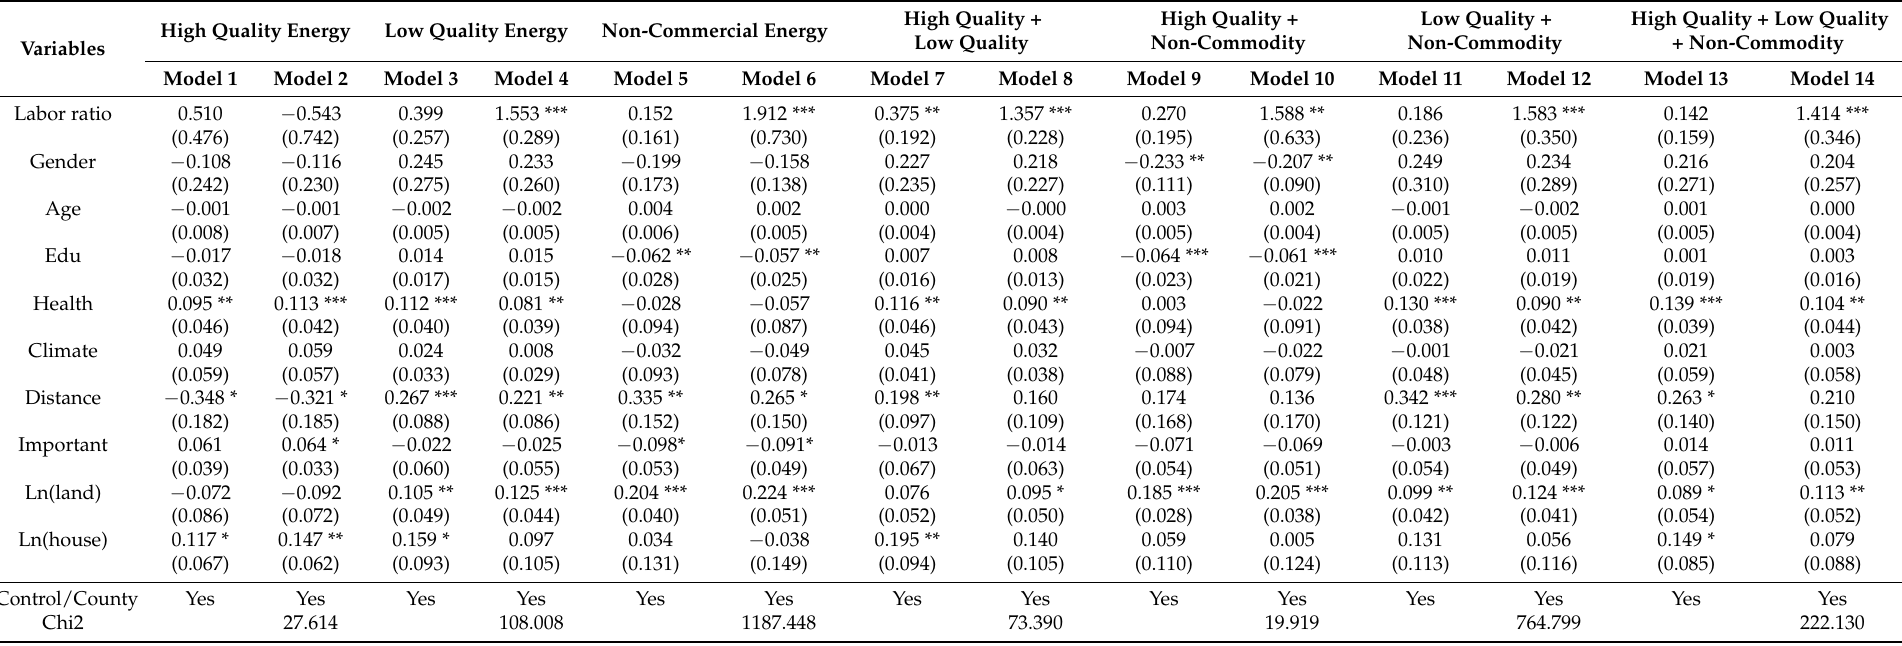
Table 2. Effects of Off-farm employment on several types of energy